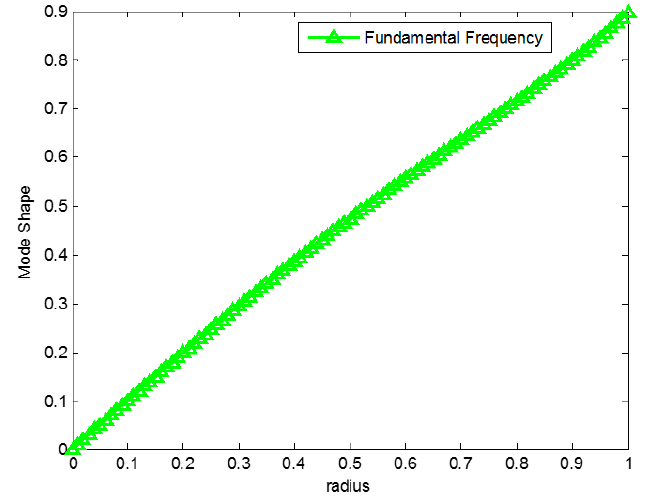
Figure 5. Fundamental mode shape of Simply Supported Condition at one edge and free at other